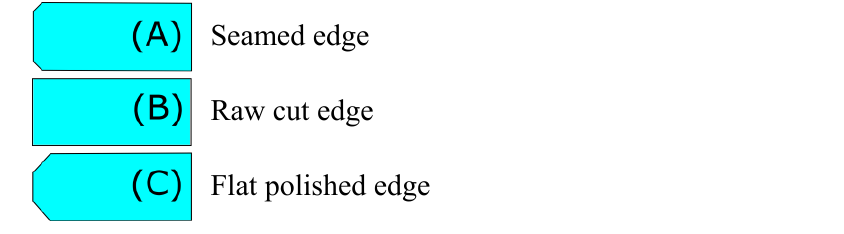
Fig. 2 Edge machining used for NAW measurements and bending testing. (A) seamed edge (swiped) which is rough with defects but the edges are lightly sanded (used before heat strengthening), (B) untreated diamond cut edge, and (C) flat polished edge with matte surface.